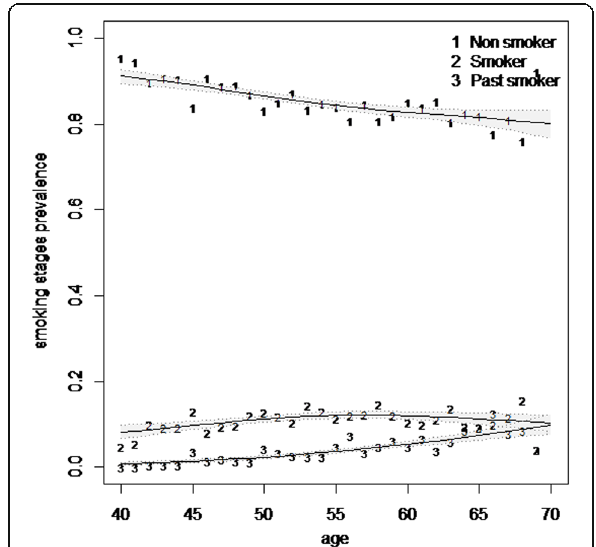
Fig. 1 Smoothed prevalence of tobacco smoking stages in Shahroud population (40 – 69 years) using multinomial P-spline. The shaded areas represent 95% confidence intervals